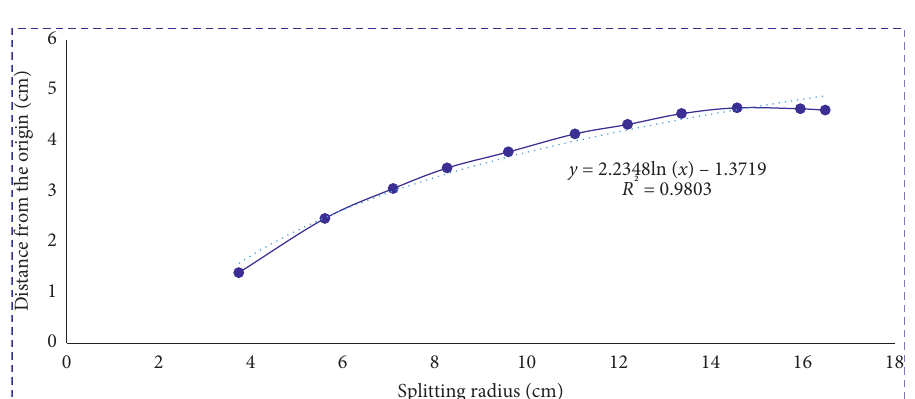
Figure 8: The first half of the curve of the envelope